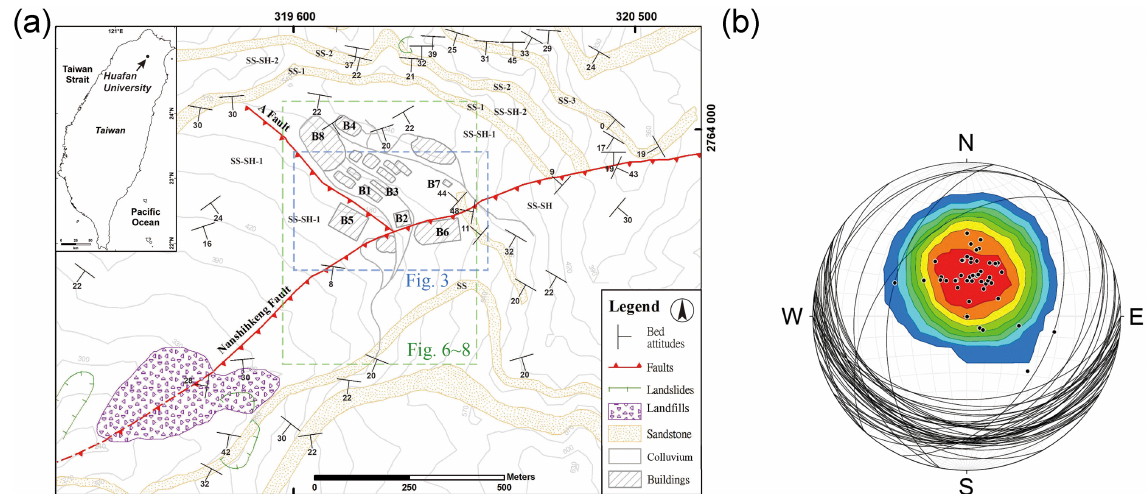
Figure 1. (a) Field case (Huafan University campus) location and geology of the study area. According to the geological investigations, not only a dip slope, but also two new faults (i.e., Nanshihkeng Fault dipping 60–70 ◦ and A Fault dipping 65–70 ◦ ) are found within the campus. Building symbols are indicated as follows: B1 is Hui-Tsui building, B2 is Wu-Ming building, B3 is Zhi-An building, B4 is dormitory, B5 is library and information (L and I) building, B6 is Asoka Square, B7 is Chea-Chau building, and B8 is sports ground. (b) A stereonet plot for the bedding measured of the Mushan Formation in the Ta-lun Shan area.